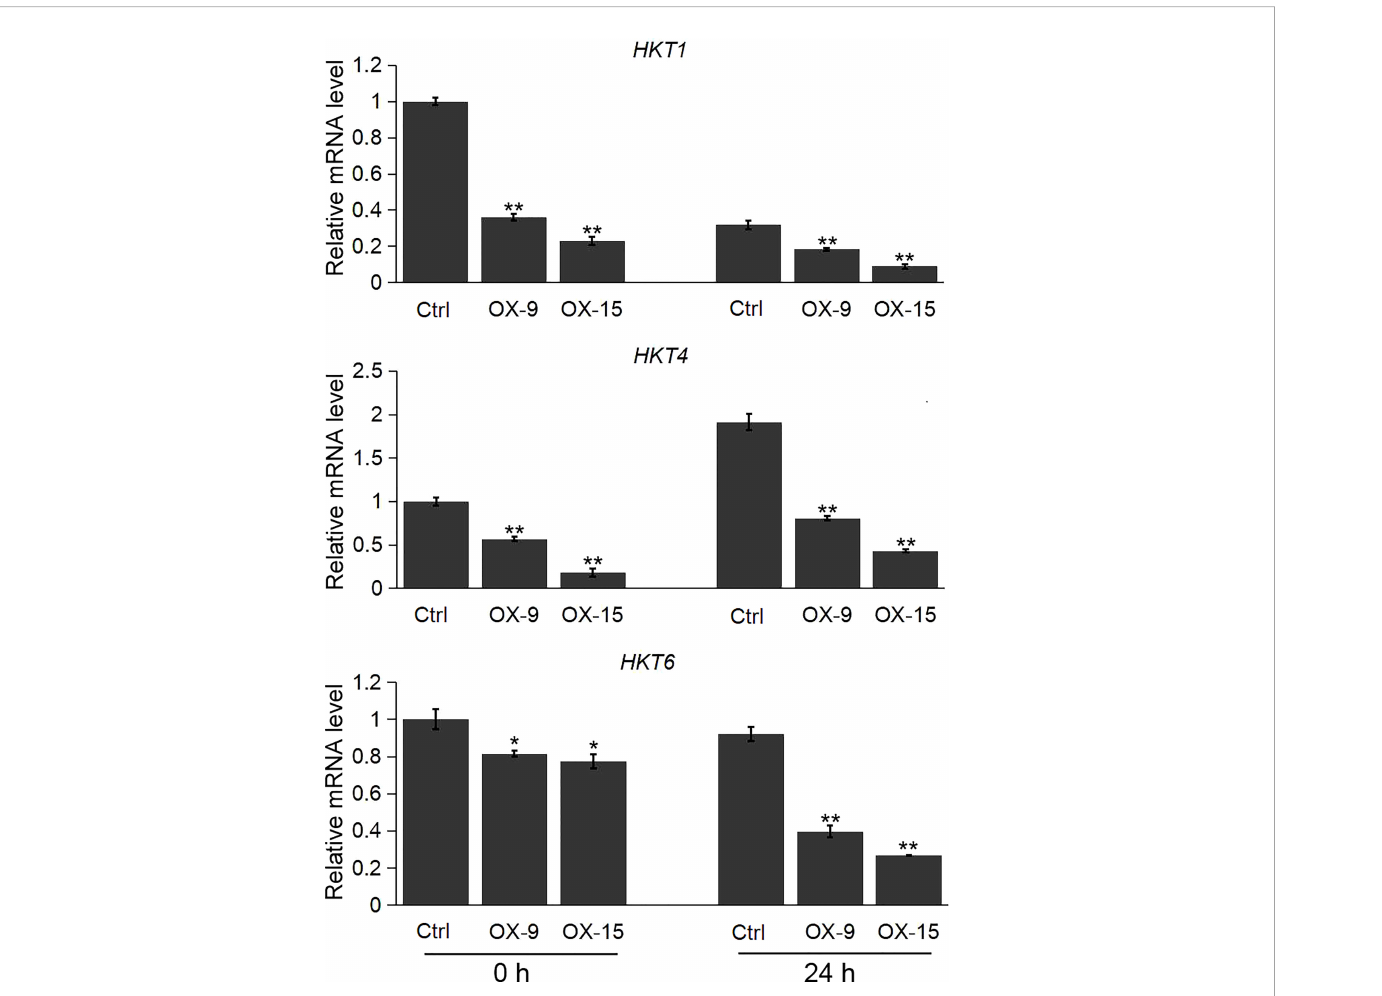
FIGURE 6 Expression analysis of HKT genes in the OsGF14C -OX transgenic plants and control plants (Ctrl) by quantitative real-time PCR. Error bars indicate the SD from three biological replicates and asterisks indicate statistically signi fi cant differences compared to the control plants ( t test, ** P <0.01; * P